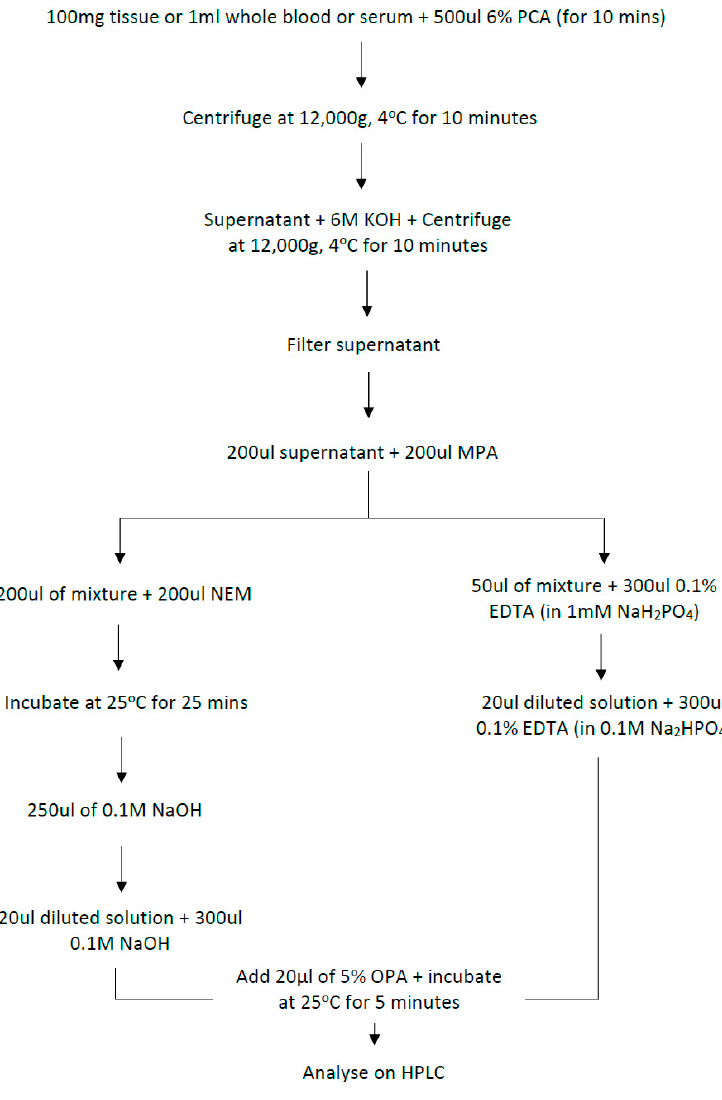
Figure 11. Schematic representation of glutathione assay protocol (every step is done on ice or at 4 °C). High performance liquid chromatography (HPLC); sodium hydroxide (NaOH); N - ethylmaleimide (NEM); potassium hydroxide (KOH); ethylenediaminetetraacetic acid (EDTA).